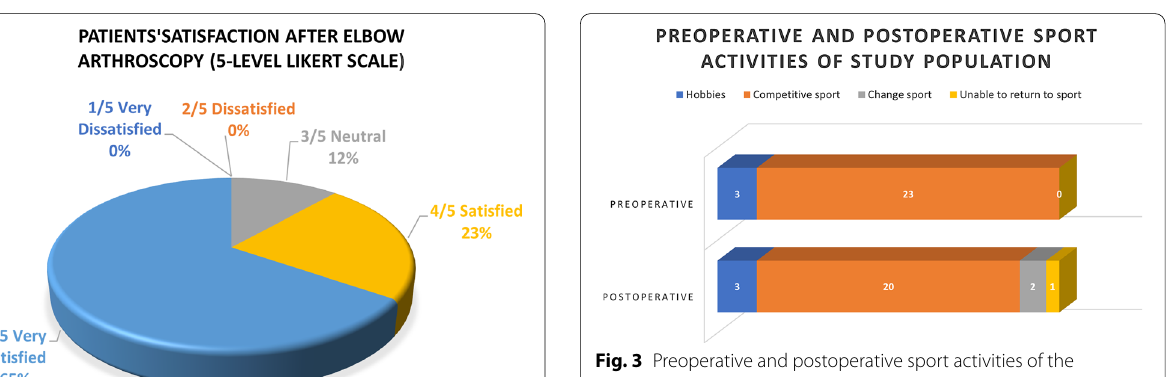
Overall clinical results of the PI group patients. For each measured outcome (flexion, extension, pronation, supination, VAS score and MEPS score) the preoperative and postoperative means (with SD standard deviation, and range with minimum/maximum value obtained), the variation, and the P -value are reported